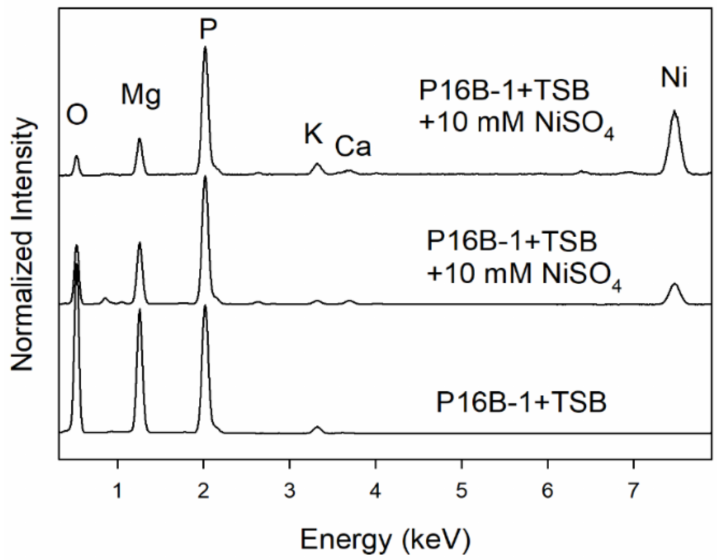
Figure 4. EDX spectra of S. mirabilis P16B-1 crystals produced with 10 mM NiSO 4 (green) and without nickel addition (white) on TSB medium. For comparison, we have rescaled the spectra by normalizing the phosphorus K peak to an intensity value of 1.0.